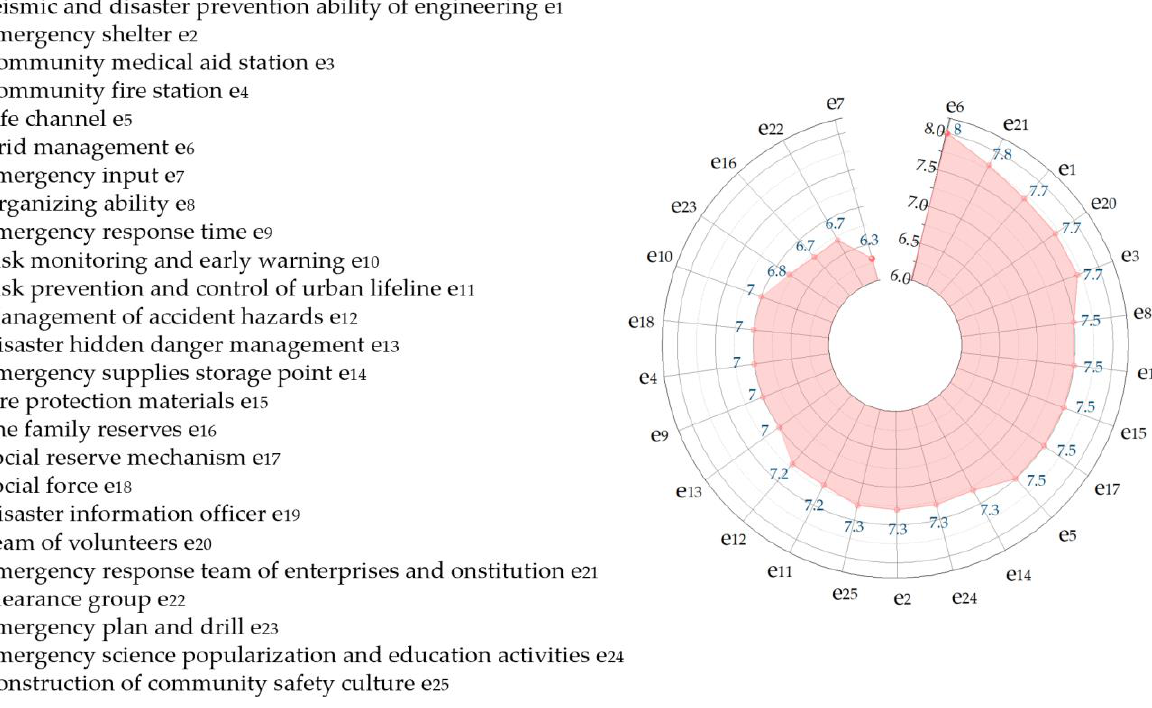
Figure 6. Specific scoring results of Level III indicators.